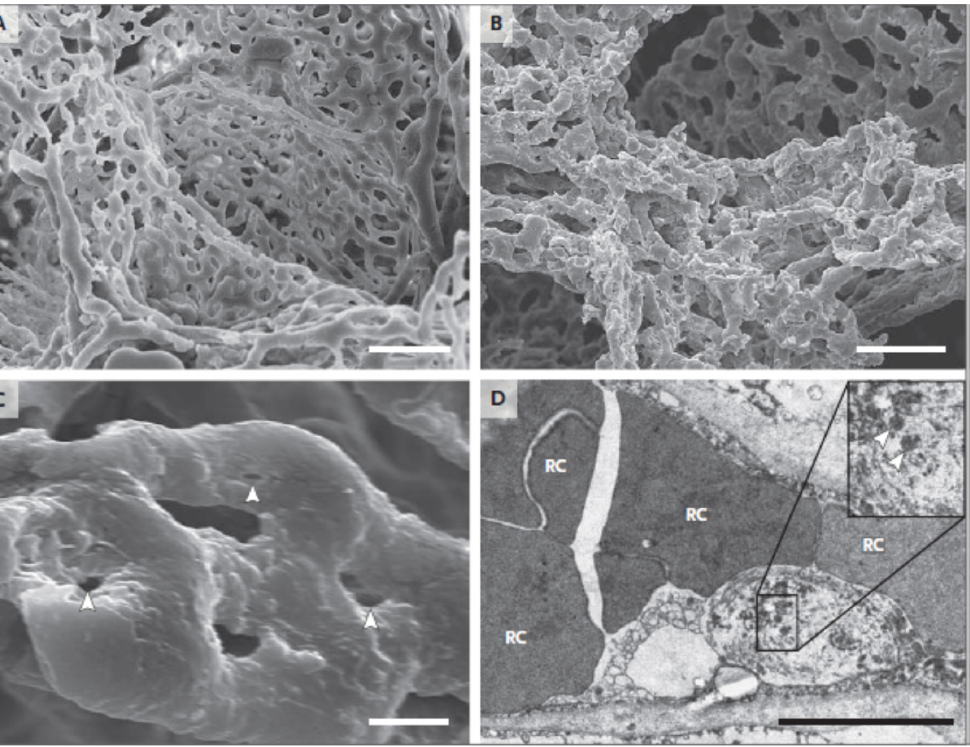
Figure 4. Scanning electron micrographs of ( A ) microvascular corrosion casts from the thin-walled alveolar plexus of a healthy lung and ( B ) the considerable architectural deformation seen in lungs harmed by COVID-19. In ( B ), the disappearance of a vascular hierarchy that was visible in the alveolar plexus is attributed to the development of new blood vessels via intussusceptive angiogenesis. ( C ) The intussusceptive pillar localizations at higher magnification, indicated by the arrowheads. ( D ) Transmission electron micrograph demonstrating ultrastructural aspects of the breakdown of endothelial cells and the presence of SARS ‐ CoV ‐ 2 within the cell membrane (arrowheads). The scale bar corresponds to 5 micrometers. RC stands for red cells [77].